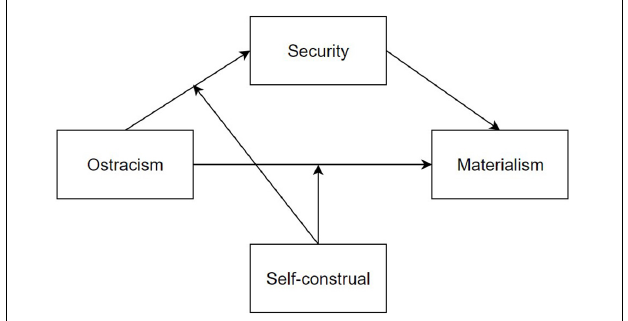
FIGURE 1 | The hypothetical